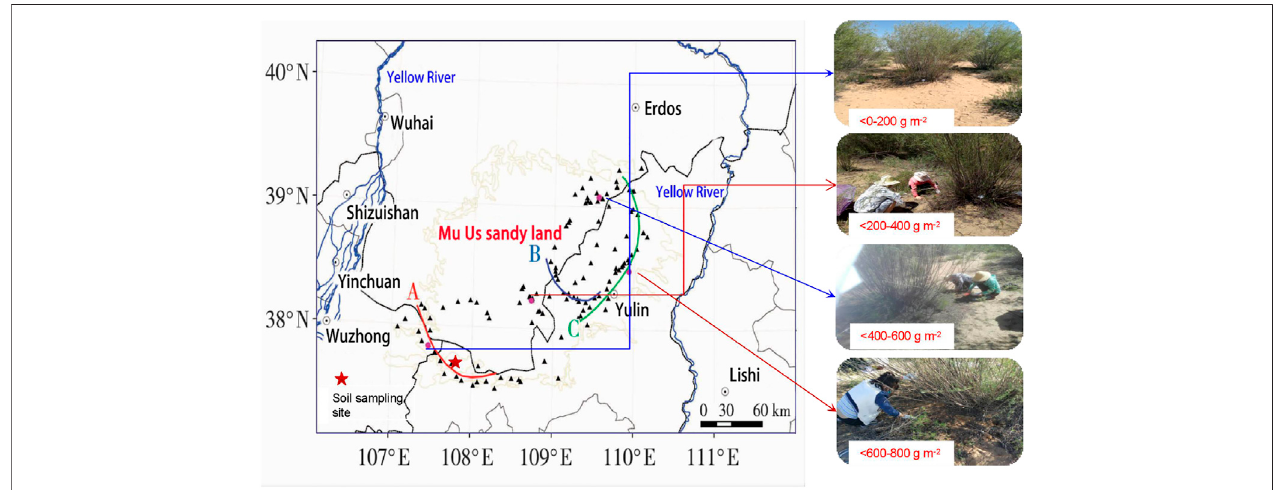
FIGURE 1 | Distribution of residual samples of Salix residual in the southeastern margin of the Mu Us Sandy Land [the survey route includes A, B, and C lines].